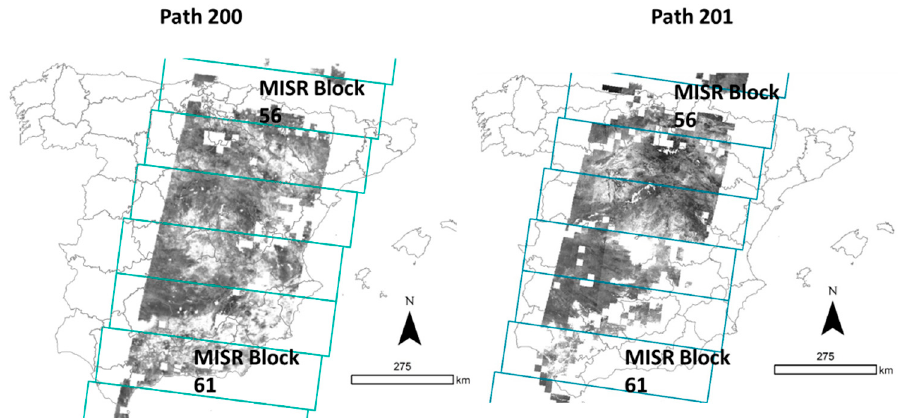
Figure 1. Examples of Multi-angle Imaging SpectroRadiometer (MISR) paths 200 and 201 used in this study. Grayscale refers to the ρ 0 value at the red channel.